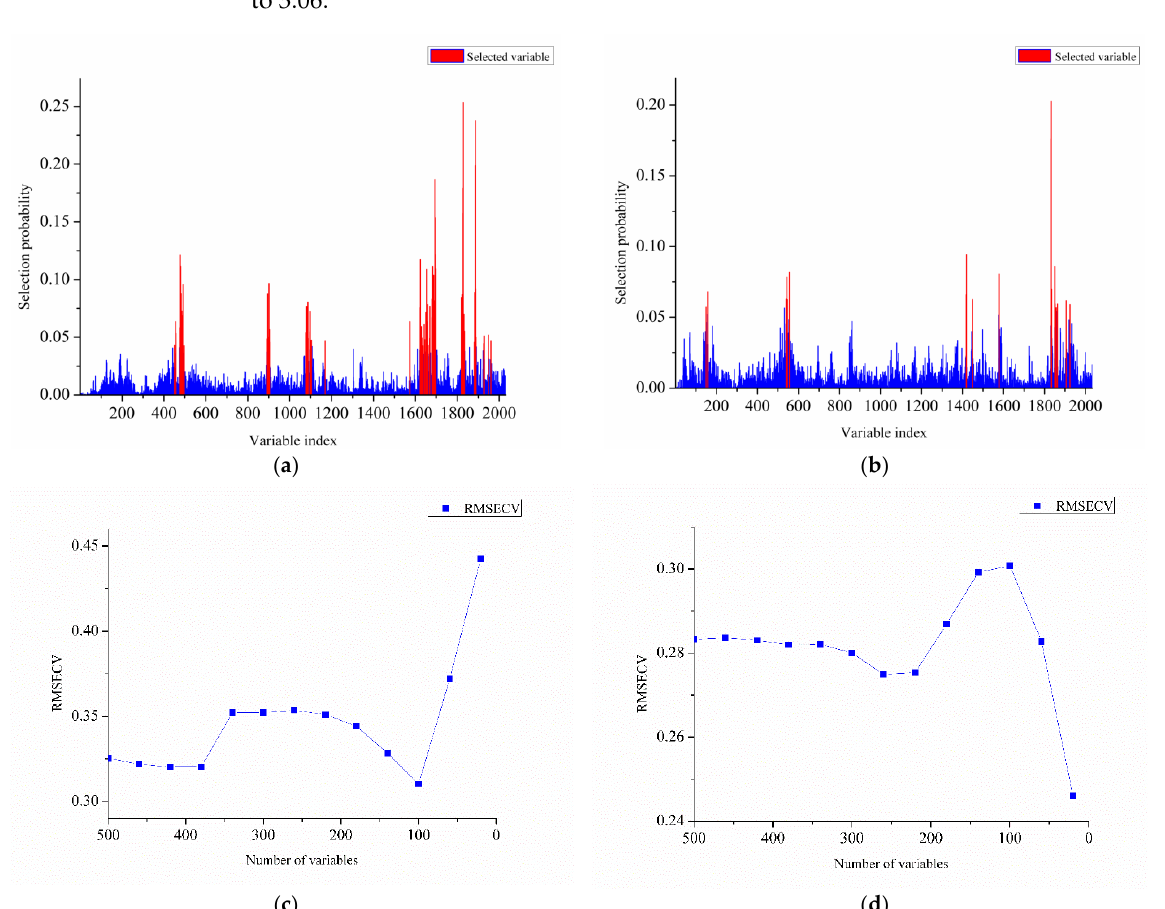
Figure 5. RF variable selection on dataset: ( a ) selection probability for each variable calculated for geniposide dataset; ( b ) selection probability for each variable calculated for baicalin dataset; ( c ) relationship between RMSECV value and number of variables of geniposide dataset ( d ) relation- ship between RMSECV value and number of variables of baicalin dataset.